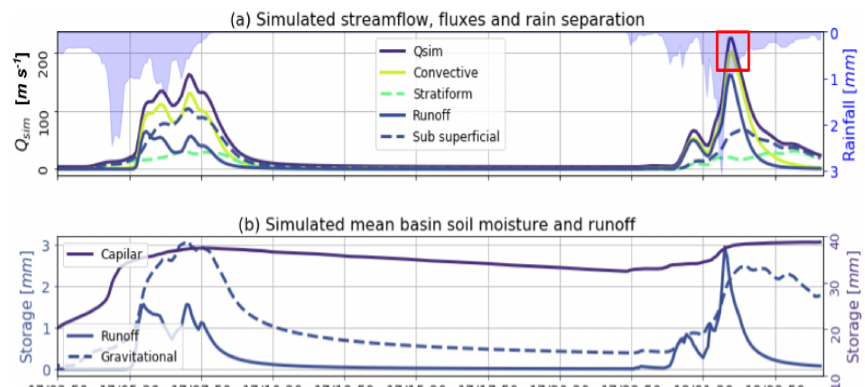
Figure 9. Summary of the results from the TETIS hydrological simulation. (a) Simulated streamflow, convective–stratiform-generated dis- charge discrimination, and runoff and subsurface flow separation. The red square represents the flash flood peak-flow interval that is estimated based on field campaign evidence. (b) Basin-average capillary, runoff and gravitational storages during the simulation